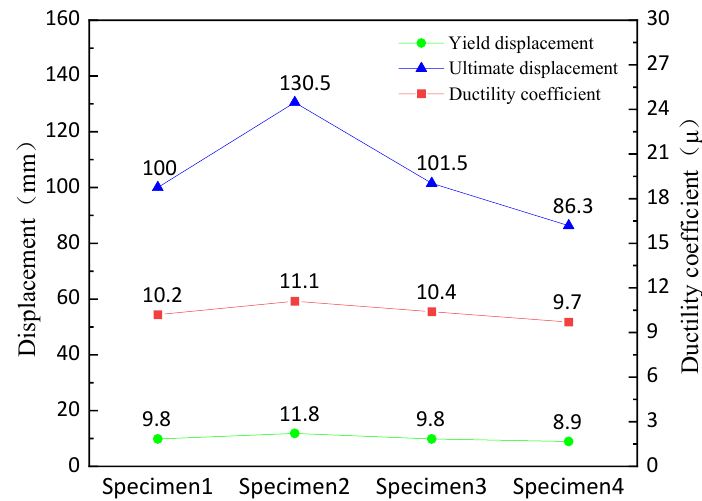
Figure 12. Comparison of displacement and ductility of each specimen.